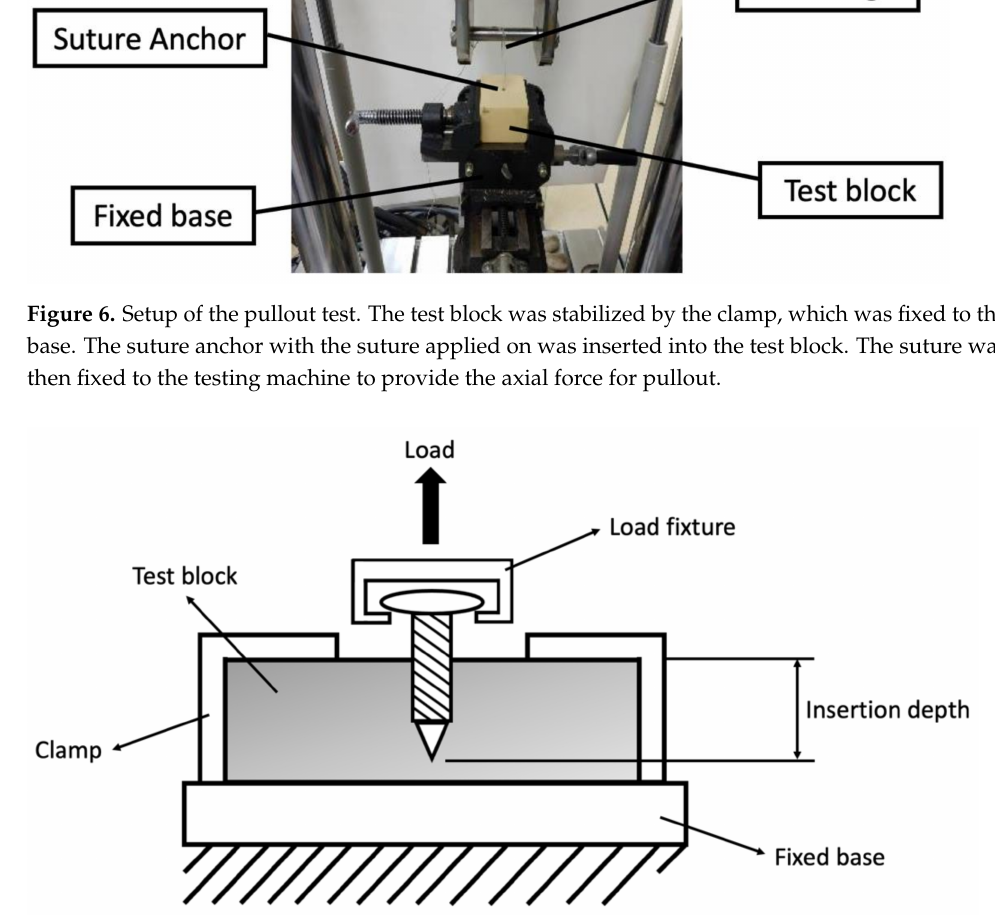
Figure 7. Test apparatus for pullout test recommended by the ASTM F543 protocol [30].